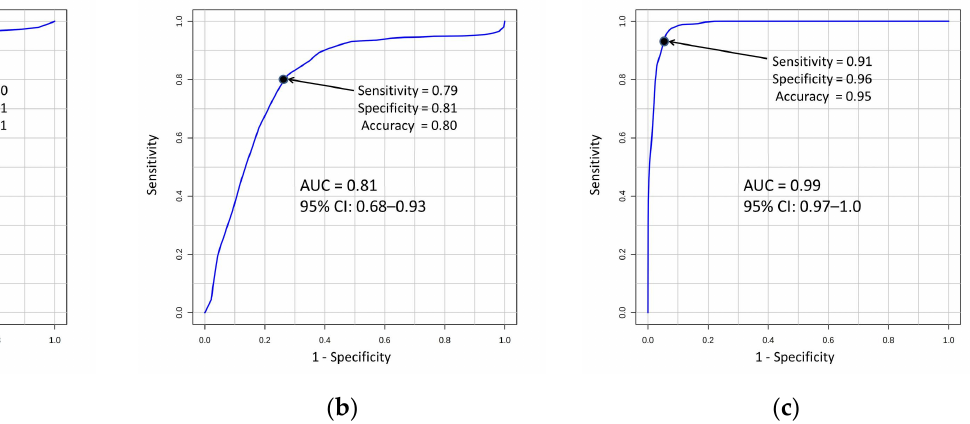
Figure 3. Receiver operator characteristic curves for the best combinations of metabolites for the accurate predictive models for: ( a ) both early and late stages of DN (T1D ‐ DN1/DN2), ( b ) T1D ‐ DN1, and ( c ) T1D ‐ DN2. AUC–area under the curve, CI–confidence interval.